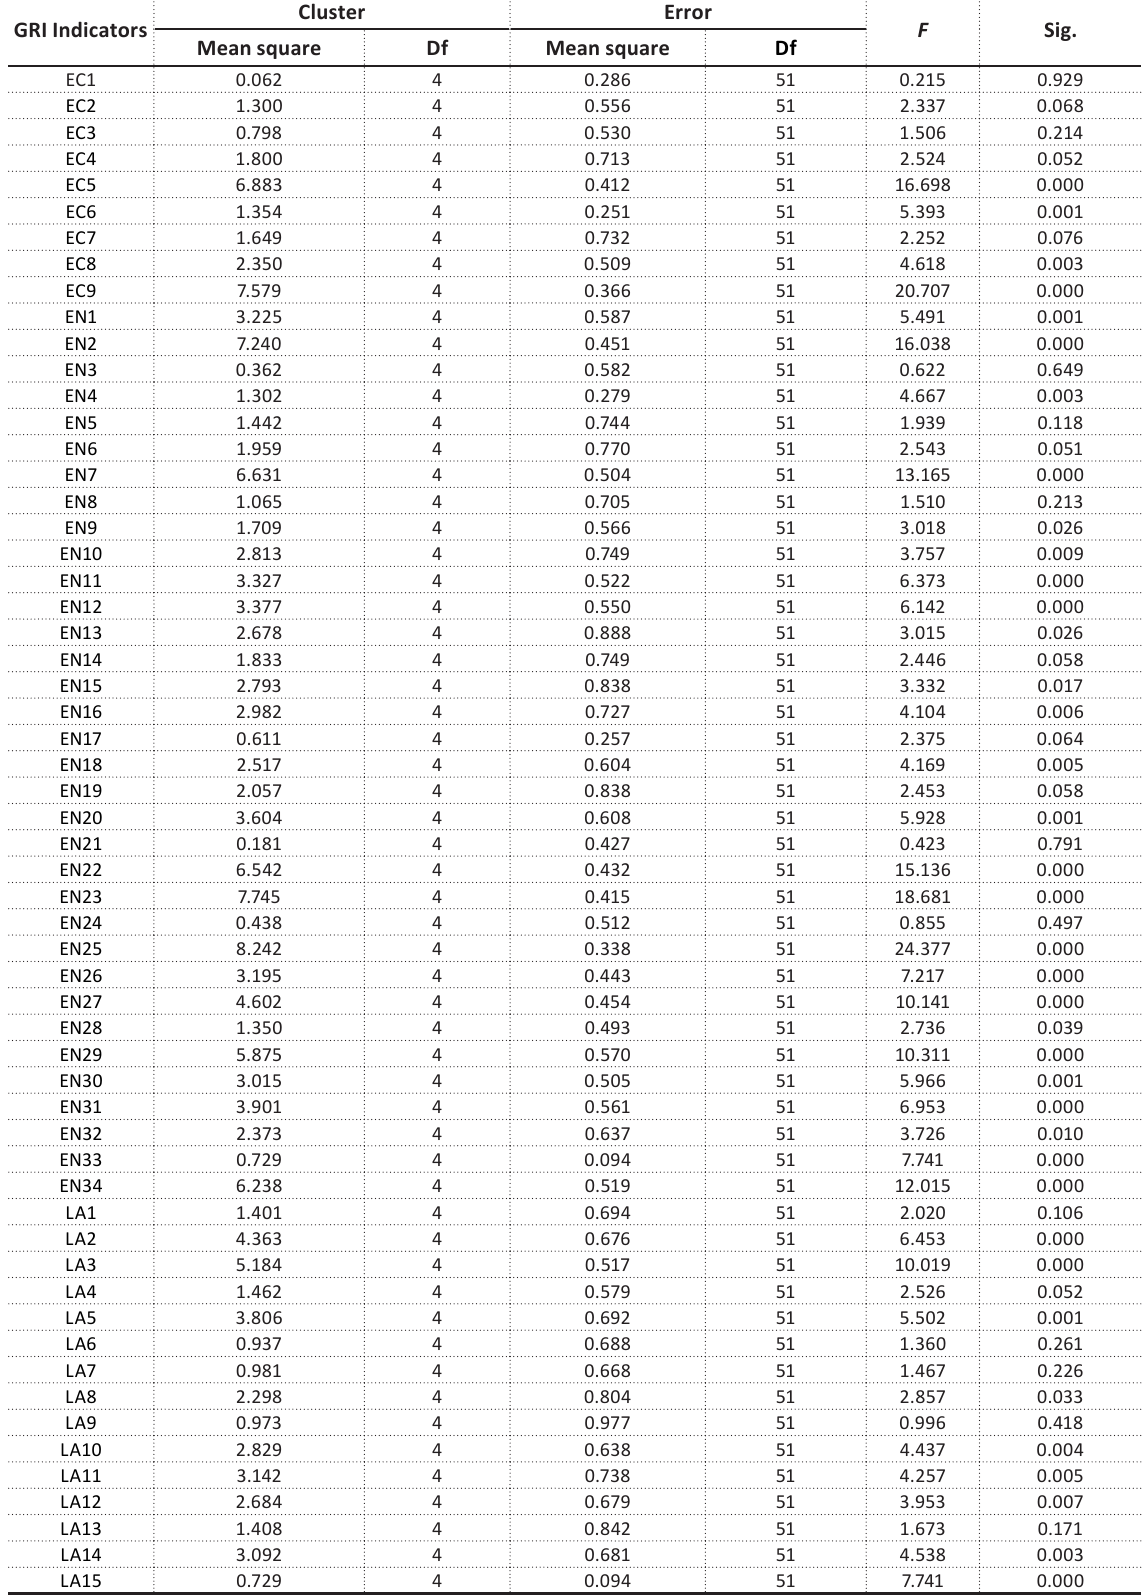
Table 2. ANOVA/ F -test results GRI